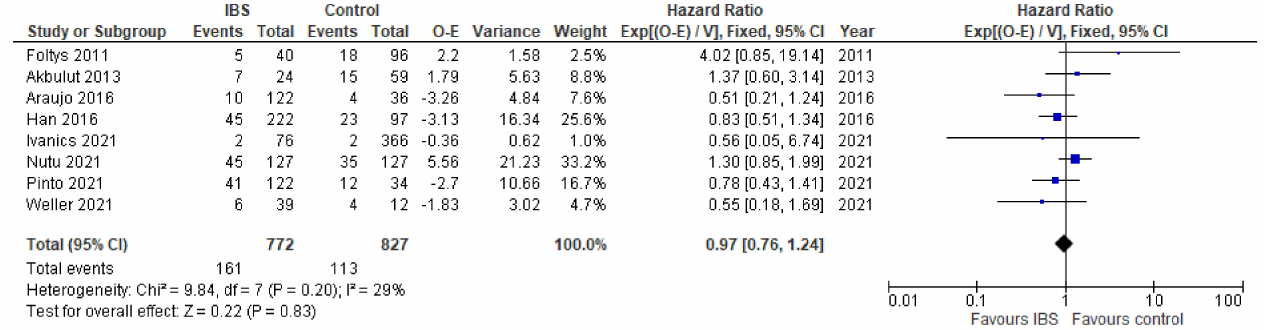
Figure 2. Forest plot for disease-free survival in liver transplant patients with IBS and without. Blue squares indicate individual effects and black diamond illustrates overall